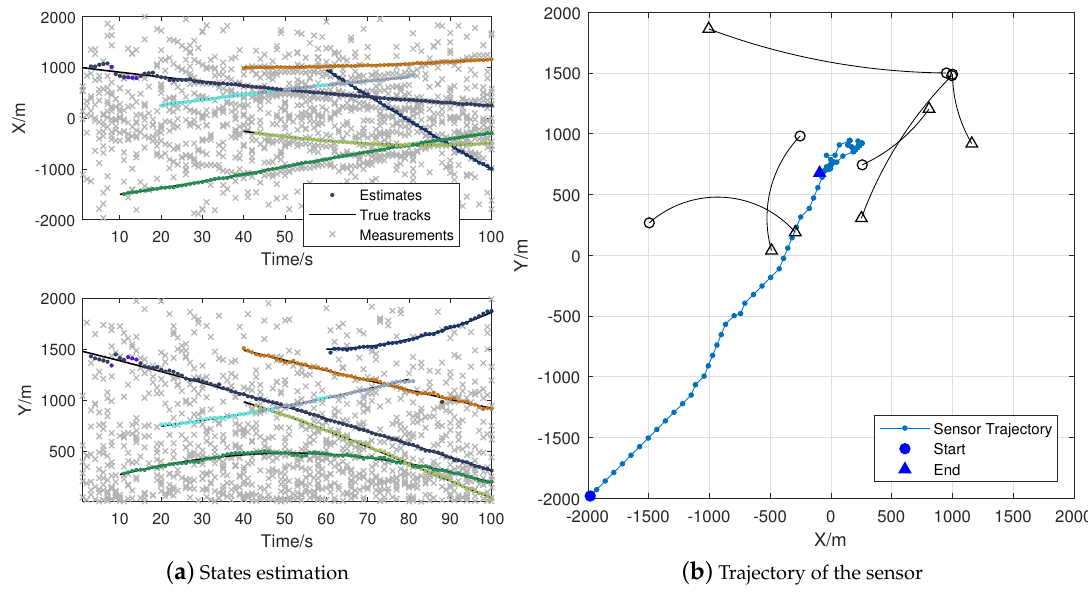
Figure 7. Dual sensor control algorithm with PDST and PDST.